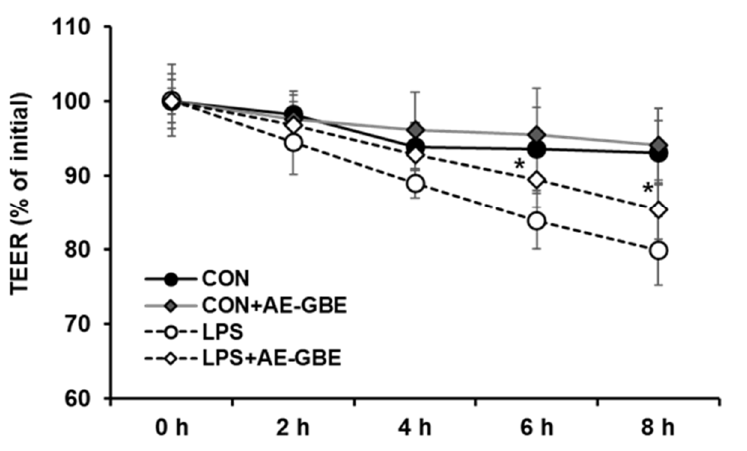
Figure 3. Protective effects of AE-GBE on permeabilization of Caco-2 cell measured by transepithelial electrical resistance method. Levels of TEER were assessed at 2, 4, 6, and 8 h after LPS or ADLE treatment. The data represent mean ± S.D. *: p < 0.05 compared with the LPS alone group, n = 3–5.